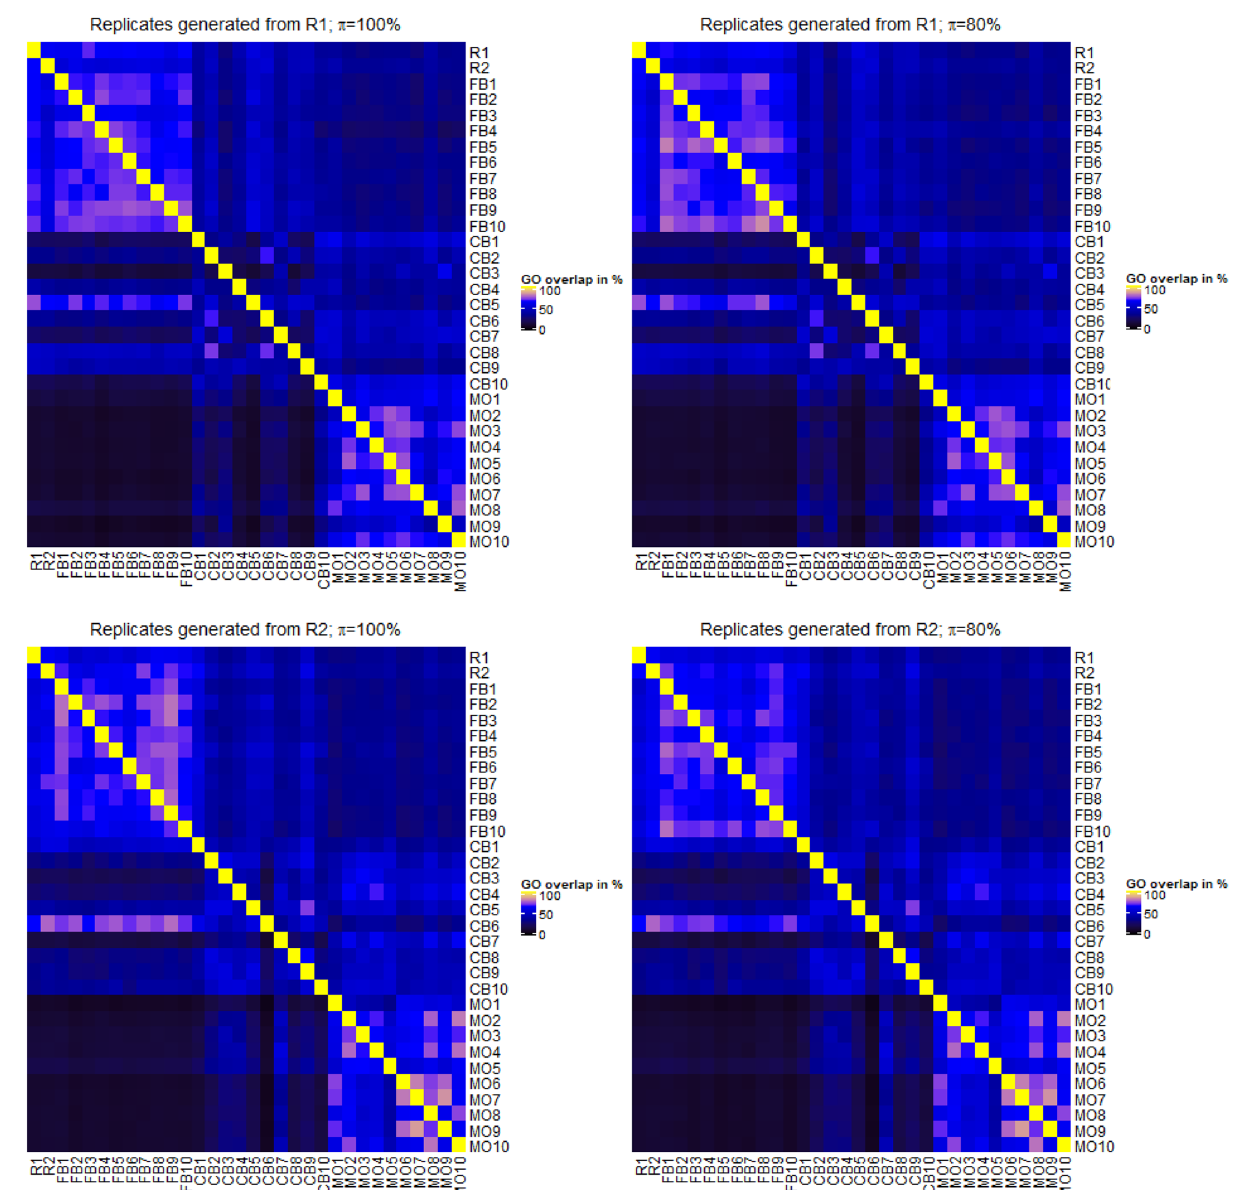
Figure 6. Heatmaps reflecting the overlap of selected enriched GO terms in the same way as the heatmaps of differentially expressed genes. Heatmaps were drawn using the R-package ‘ComplexHeatmap’ (version 2.6.2., www. bioco nduct or.